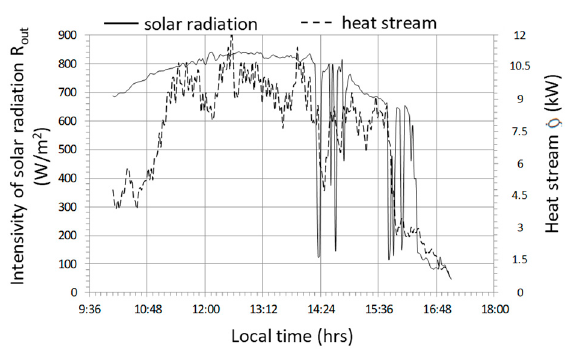
Figure 23. Timescale of solar radiation intensity and heat stream transferred to the accumulator for cycle No. 3.